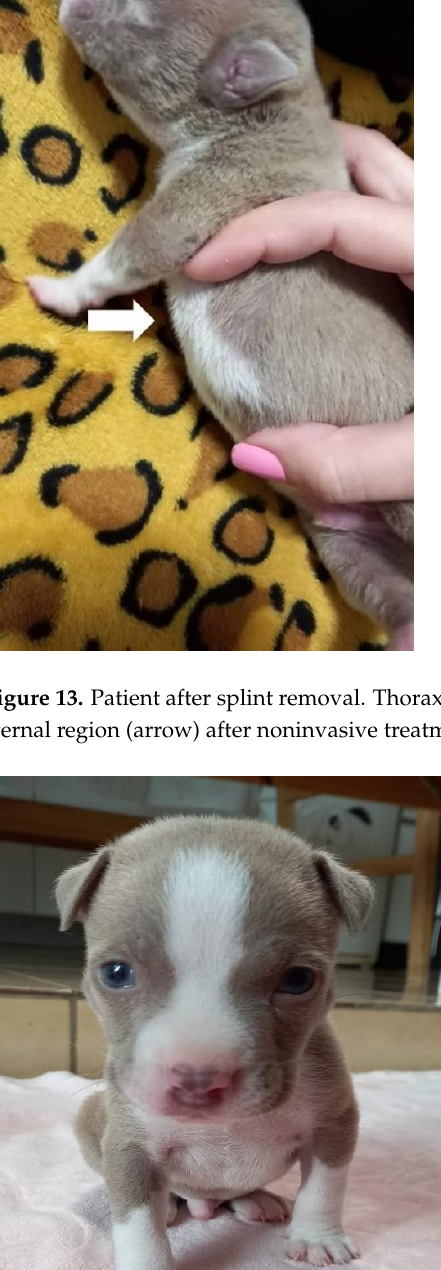
Figure 14. Puppy at 30 days old.